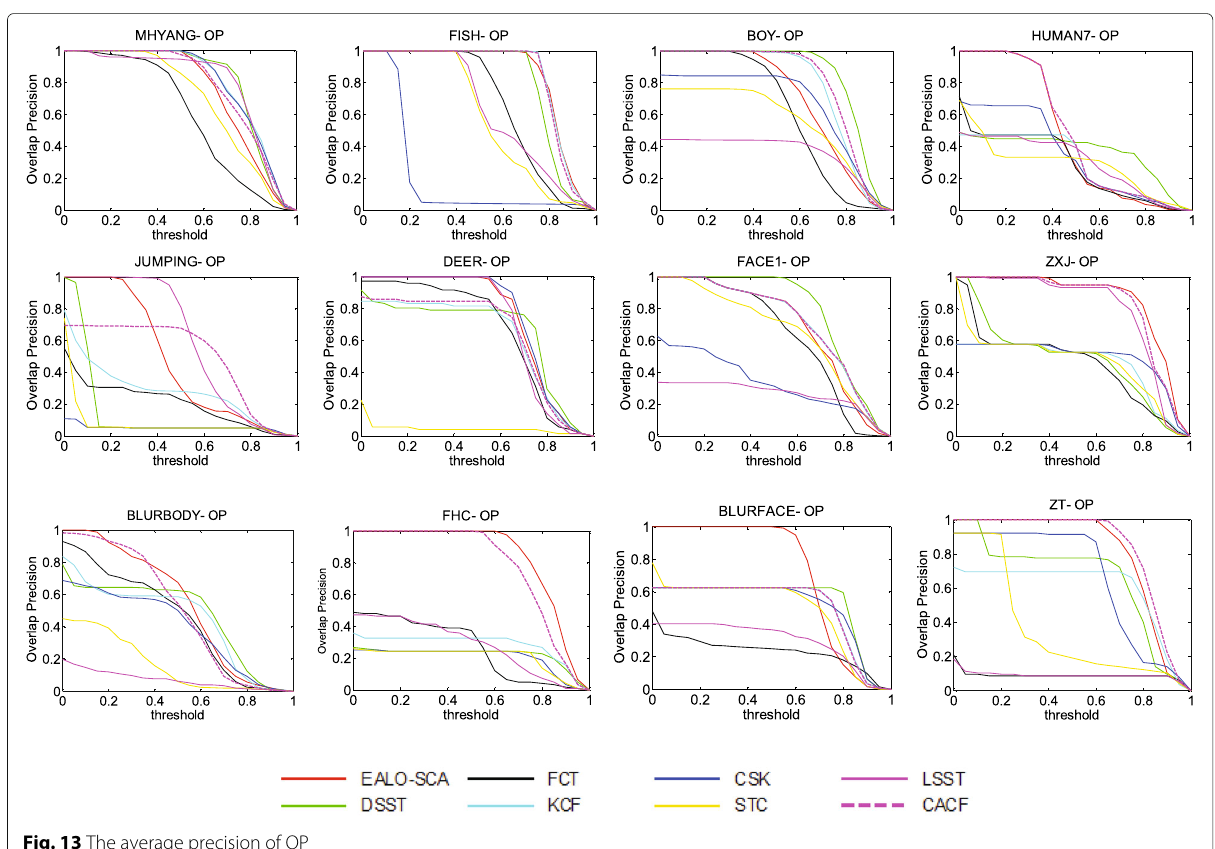
Fig. 13 The average precision of OP